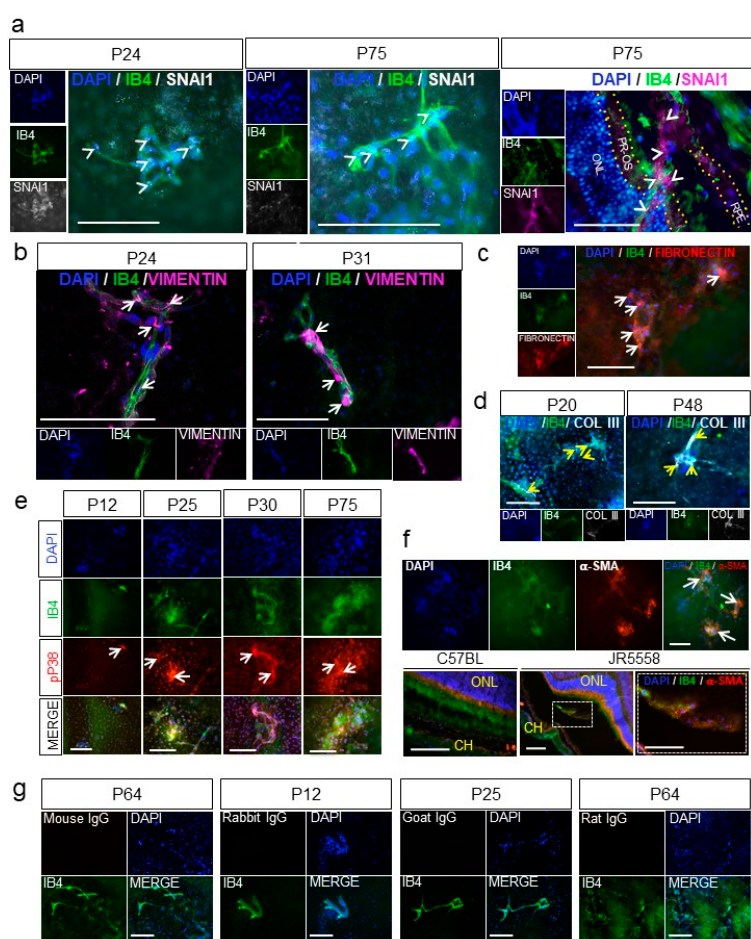
Figure 5. EndoMT and fibrosis are associated with spontaneous choroidal neovascularization (CNV) in a mouse model of wet age-related macular degeneration (AMD). ( a ) Nuclear expression of the zinc-finger transcription factor SNAI1 (white, arrowheads) by the endothelial cells of the CNV (IB4, green) was visualized by immunostaining flat-mount whole retinal pigment epithelium (RPE)–choroid eyecups from JR5558 mice at P24 (left panels) and P75 (middle panels). Cross sections of the RPE–choroid showing the CNV at P75 (arrowheads, right panel) were also immunostained for SNAI1 (purple). ONL, outer nuclear layer; PR-OS, photoreceptor outer segment; RPE, retinal pigment epithelium are outlined by yellow dotted lines. ( b ) Expression of vimentin (purple) in the vessels of the CNV (IB4, green) was visualized by immunostaining flat-mount whole RPE–choroid eyecups from JR5558 mice at P24 and P31. Note the increase in vascular staining of vimentin in the CNV at P31 compared to P24. ( c ) Colocalization of fibronectin expression (red) and the vessels of the CNV (IB4, green, arrows) was visualized by immunostaining flat-mount whole RPE–choroid eyecups of JR5558 mice at P70. ( d ) Collagen type III expression (white, yellow arrows) was visualized in developing CNV in flat-mount whole RPE–choroid eyecups from JR5558 mice at P20 and P48. ( e ) Co-localization of phospho-p38 MAPK (pP38, red) expression with the vessels of the CNV lesions (IB4, green arrows) was visualized by immunostaining flat-mount whole RPE–choroid eyecups from JR5558 mice at ages P12 to P75. ( f ) Expression of α -SMA (red) was visualized in vessels of CNV lesions (isolectin B4, green) by immunostaining flat-mount whole RPE–choroid eyecup tissues from P70 JR5558 mice (top panels), and histological sections of RPE–choroid tissues from P70 wild-type C57BL/6J and JR5558 mice (bottom panels). Co-localization of α -SMA with the CNV is shown with the arrows; the area of higher magnification in the cross section of the CNV lesion is indicated by the dotted lines. ONL, outer nuclear layer; CH, choroid layer. ( g ) Appropriate IgG controls were used for immunostaining at various time points. In micrographs of all panels, scale bars = 100 µ